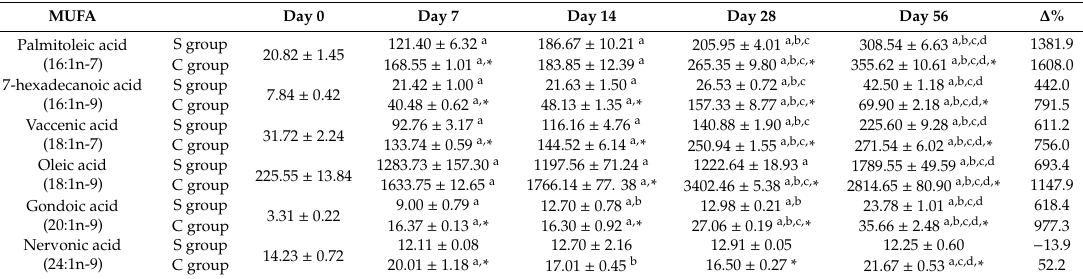
Table 4. Monounsaturated fatty acid (MUFA) composition (mg / 100 g of sample) in the livers of mice fed with a diet containing soybean oil (S group) or canola oil (C group) as a lipid source, at 0, 7, 14, 28, or 56 days after starting the diets.